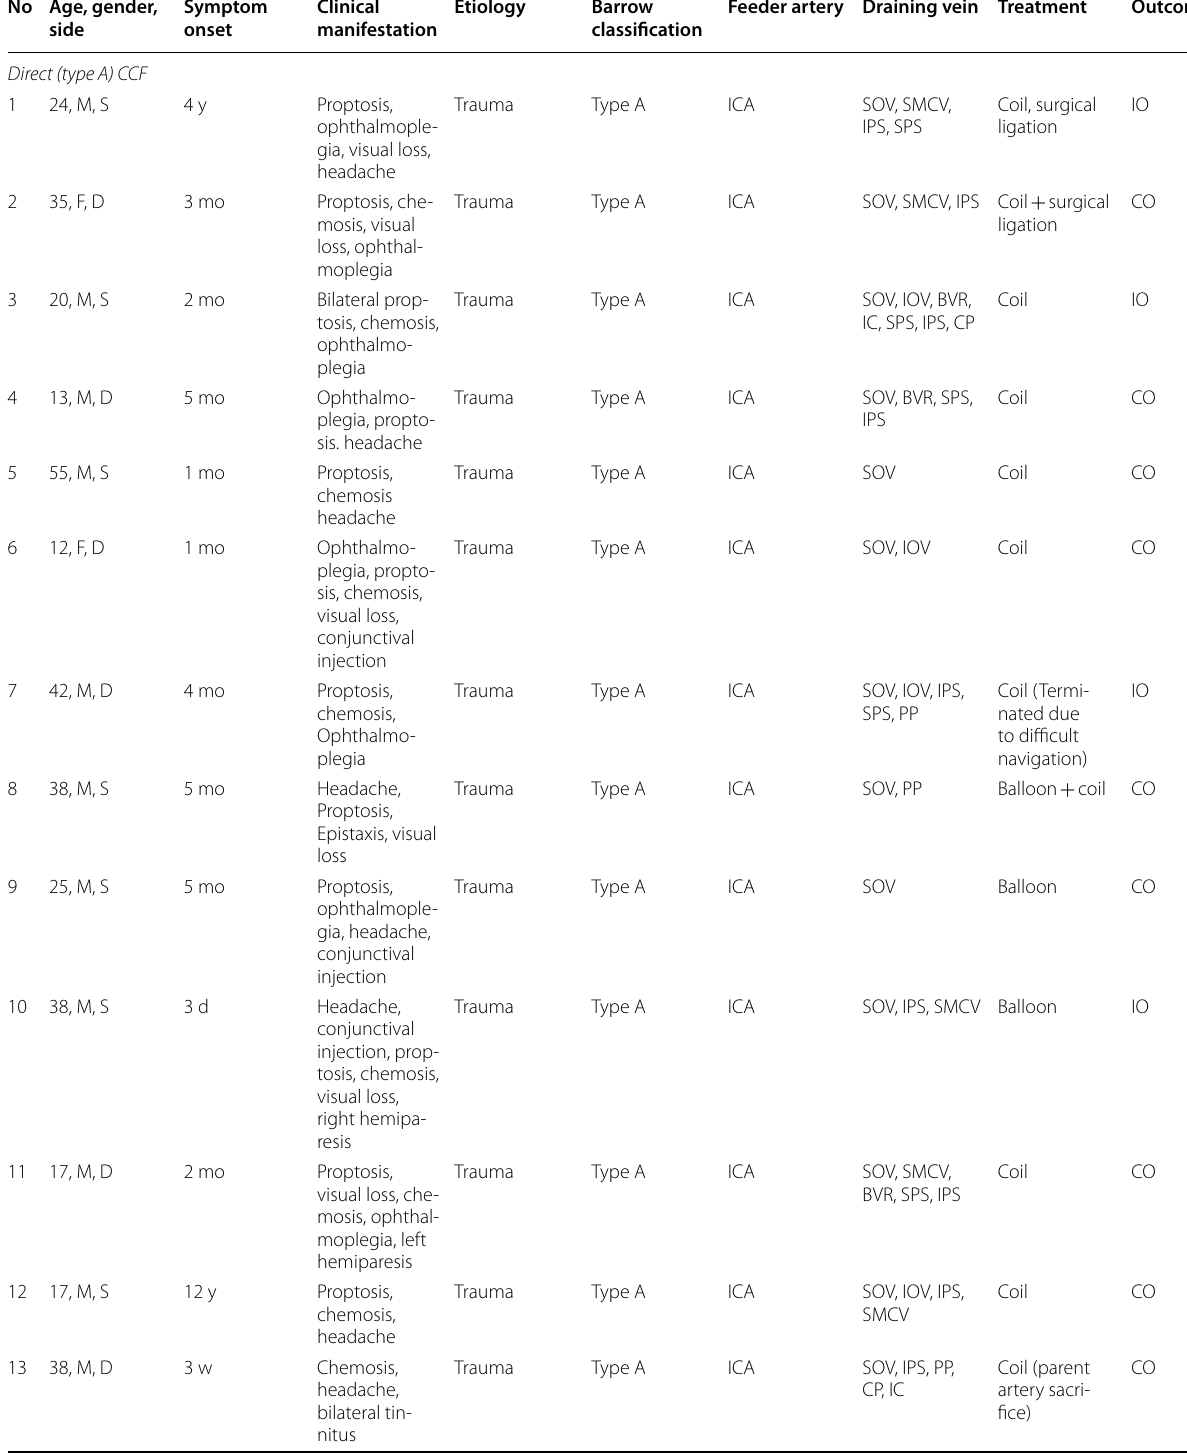
Table 1 Clinical, angiographic characteristics and treatment outcome of 24 patients with carotid cavernous fistula No Age, gender, Symptom Clinical Etiology Barrow Feeder artery Draining vein Treatment side onset manifestation classification